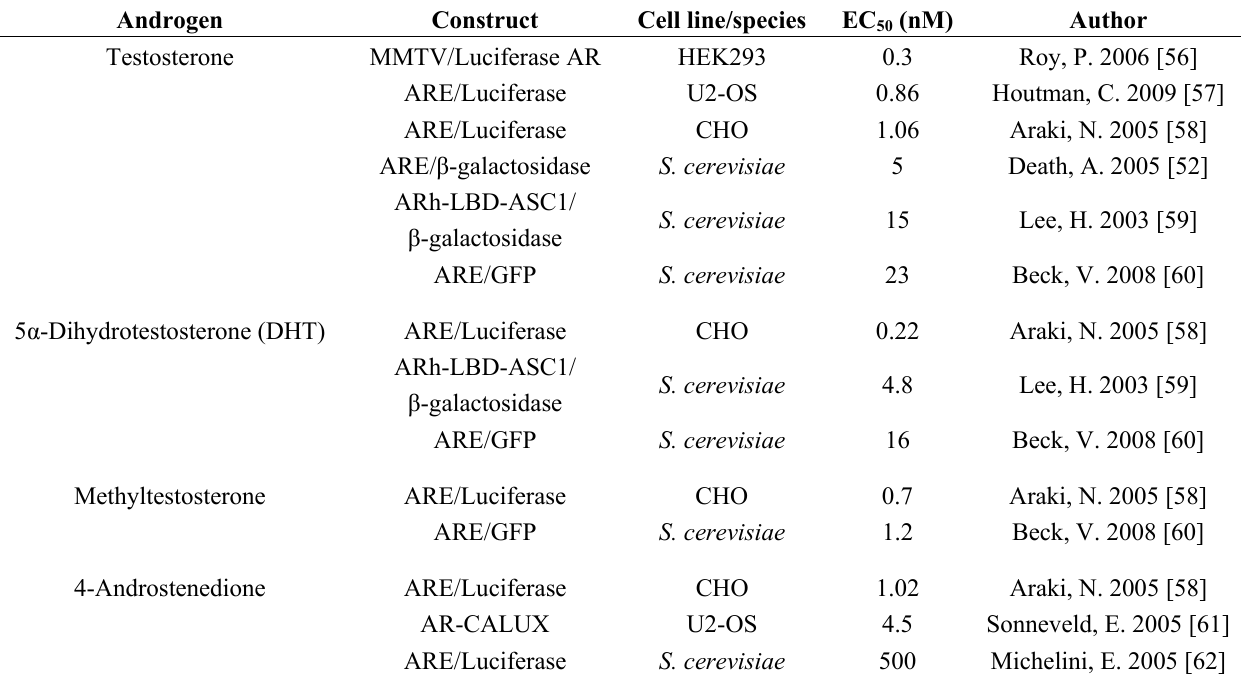
Table 1. Sensitivities of various androgen